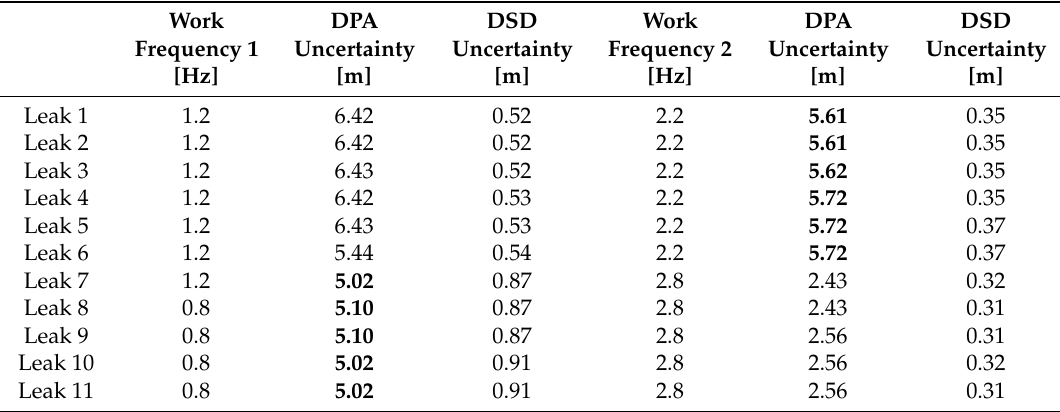
Table 1. Final results and comparison between both techniques in two work frequencies. The uncertainty is here intended as “ ± ”, and data have been treated using linear